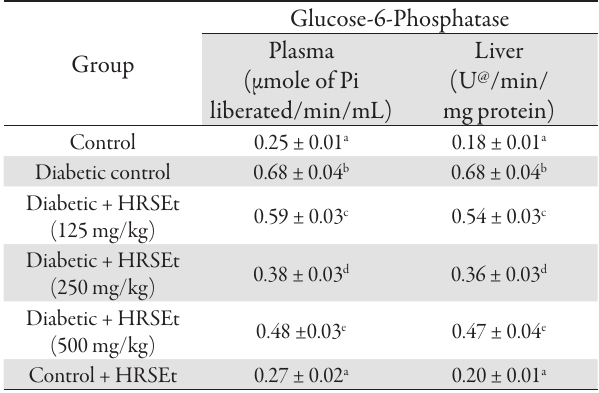
Tab. 2. Effect of HRSEt on Total Hemoglobin and Glycosylated Hemoglobin levels of control and experimental rats